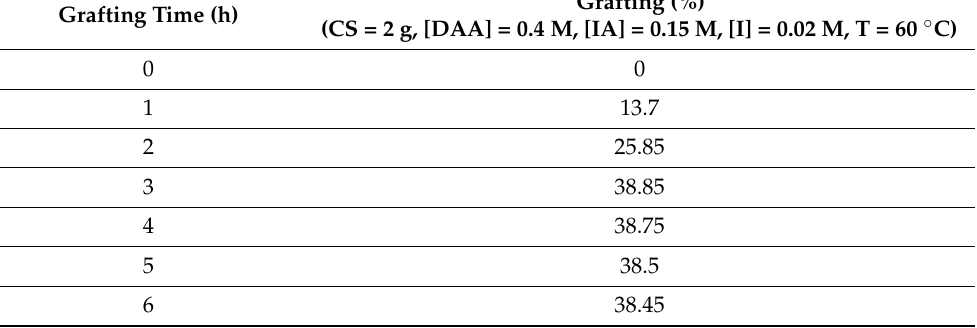
Table 3. Effect of time on the graft percentage.